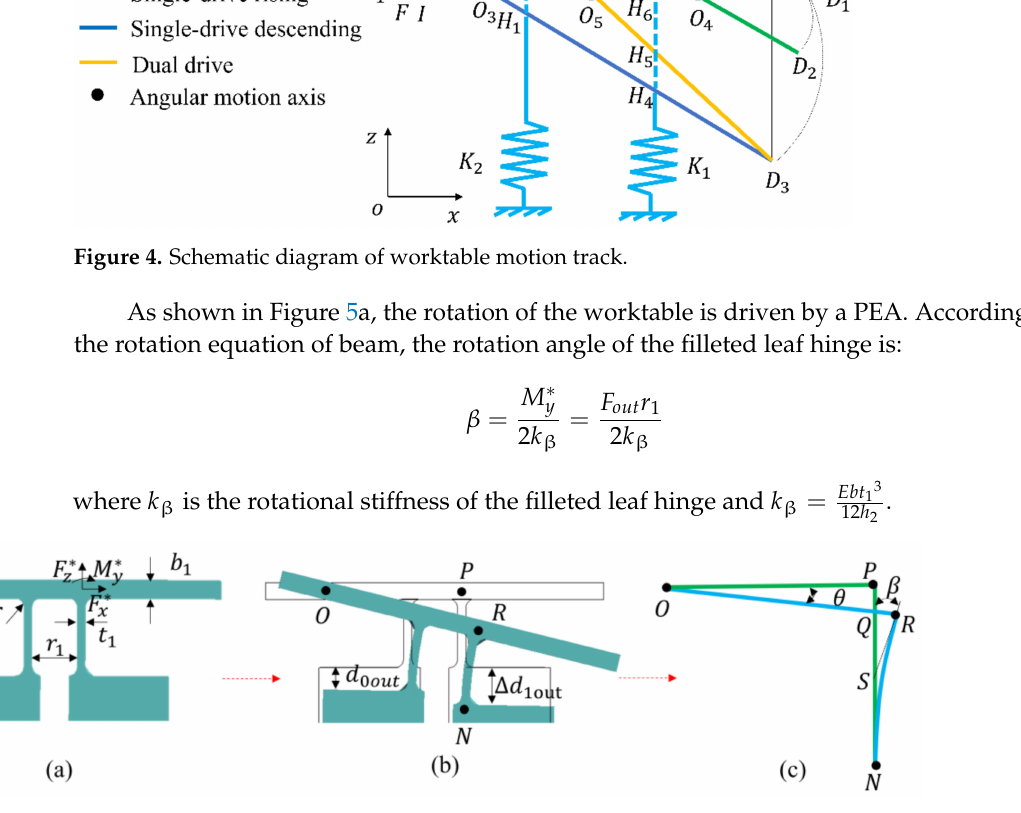
Figure 5. ( a ) Worktable and rotation hinge. ( b ) Single-drive deformation diagram. ( c ) Single-drive deformation geometric